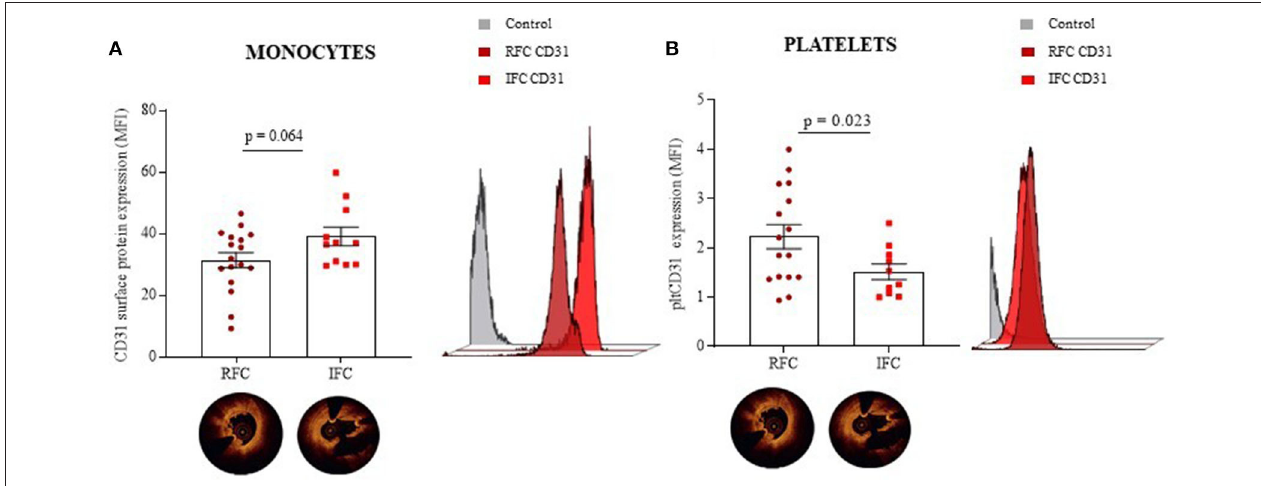
FIGURE 4 | CD31 expression on monocytes and platelets according to OCT investigation. Dot plots (mean ± SD) and related representative overlay histograms showing the surface protein expression of CD31 within the NSTEMI group that underwent an OCT investigation on CD14 + monocytes (A) , and CD42b + platelets assessed by flow cytometry (B) , in basal conditions. (NSTEMI, Non-ST-Elevation Myocardial Infarction; mo CD31, monocyte CD31; plt CD31, platelet; RFC, Ruptured Fibrous Cap; IFC, Intact Fibrous Cap; and MFI, Median Fluorescence Intensity.